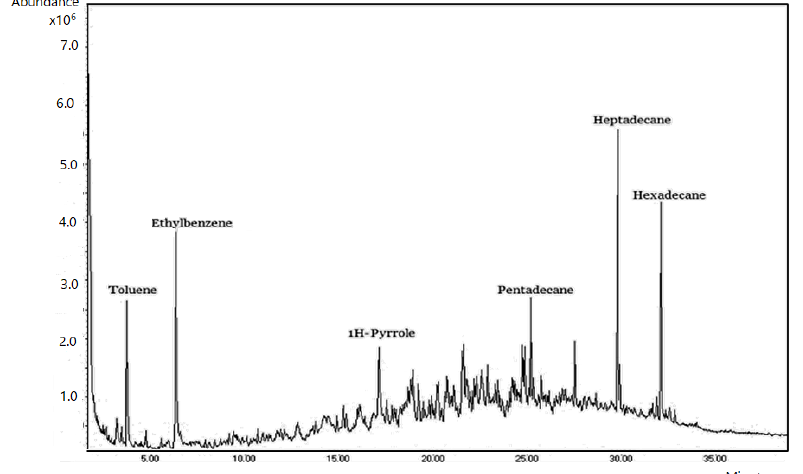
Figure 3. GC-MS analysis of compounds in the HDO upgraded product obtained from algal bi- ocrude using Ru/C catalyst (HDO conditions: 350 °C, 2 h, 10 wt% Ru/C).